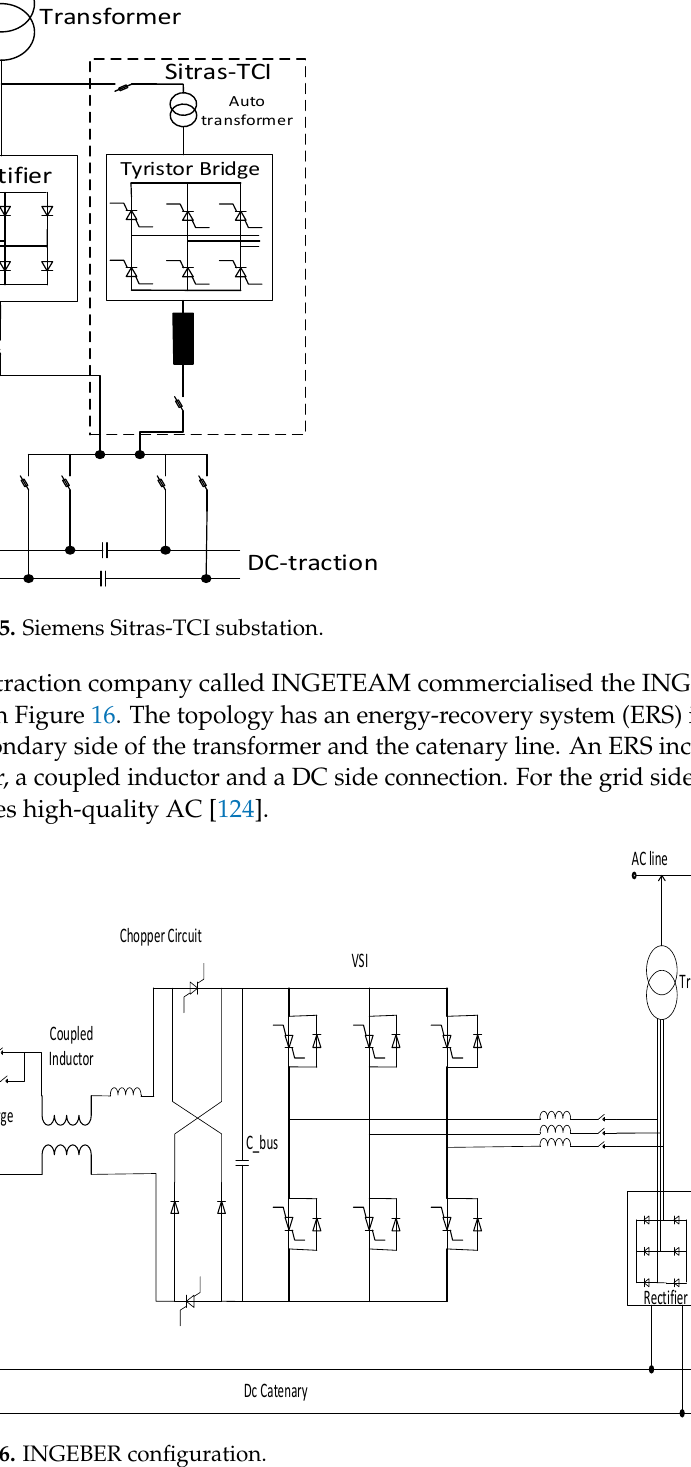
Figure 16. INGEBER configuration. Figure 16. INGEBER